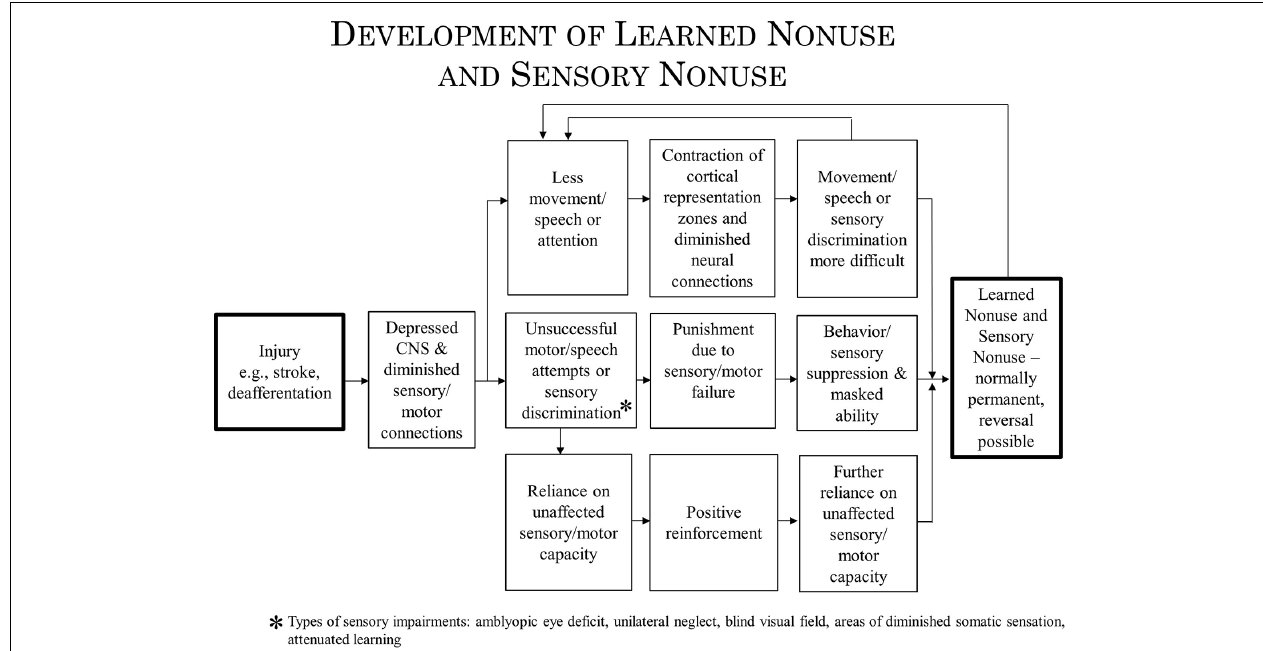
FIGURE 8 | Schematization of the development of learned nonuse and sensory nonuse.